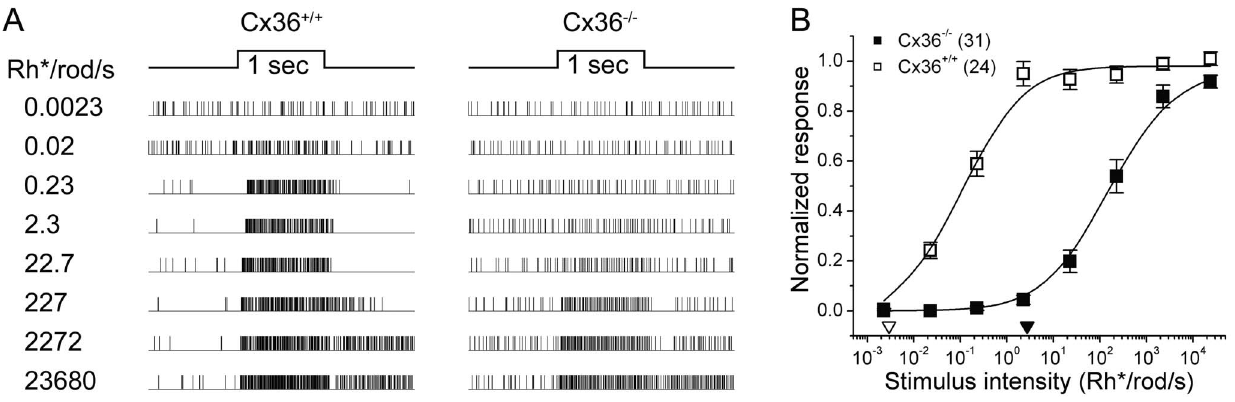
Figure 3. Light-evoked synaptic inputs to ipRGCs are less sensitive in Cx36 knockout mice. A : Raster displays comparing responses of a single representative ipRGC in a Cx36 knockout mouse (right column) with those of an ipRGC in a wildtype littermate (left column). Responses of each cell are shown for a series of 500 nm flashes of increasing intensity. The dimmest stimulus evoking a clear response was approximately three log units higher in the Cx36 KO mouse ( , 22.7 Rh * /rod/s) than it was in the wildtype control (0.02 Rh*/rod/s; see also the data for the C57Bl76 control mice; Fig. 2). B : Group data comparing irradiance-response curves for ipRGCs recorded in the Cx36 knockout (black squares; n=31) and wildtype animals (open squares; n=24). Data come from 4 pairs of littermates consisting of one wildtype and one knockout animal. The triangles near the abscissa indicate the response thresholds (5% of maximum; open triangle, Cx36 + / + ; filled triangle, Cx36 2 / 2 ), which are about 3 orders of magnitude higher in the knockouts than in the wildtype mice. This reduction in sensitivity presumably reflects the loss of input from the primary rod